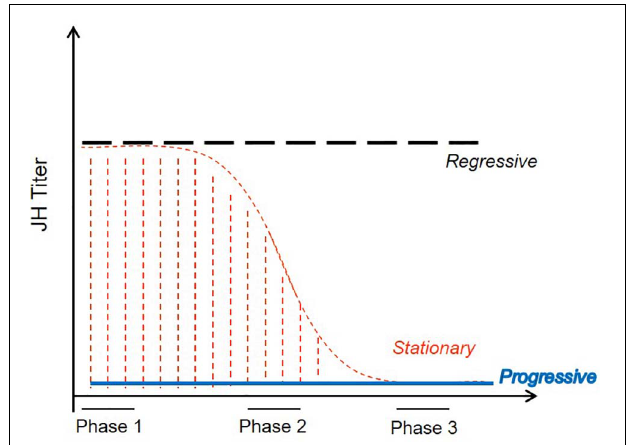
FIGURE 6 | According to current results, revised model to explain the unparalleled diversity of postembryonic, non-terminal developmental trajectories of wood-dwelling termites. High JH titers throughout the intermolt period increase the likelihood of regressive development (black, broken line). Progressive molts (blue, continuous line) require low JH titers throughout the intermolt period. Stationary molts (orange, dotted line), by contrast, can have medium-high JH titers during phase 1 but require increasing low JH titers thereafter. The presence of reproductives and soldiers prevent terminal molts into the corresponding castes. For further information, see